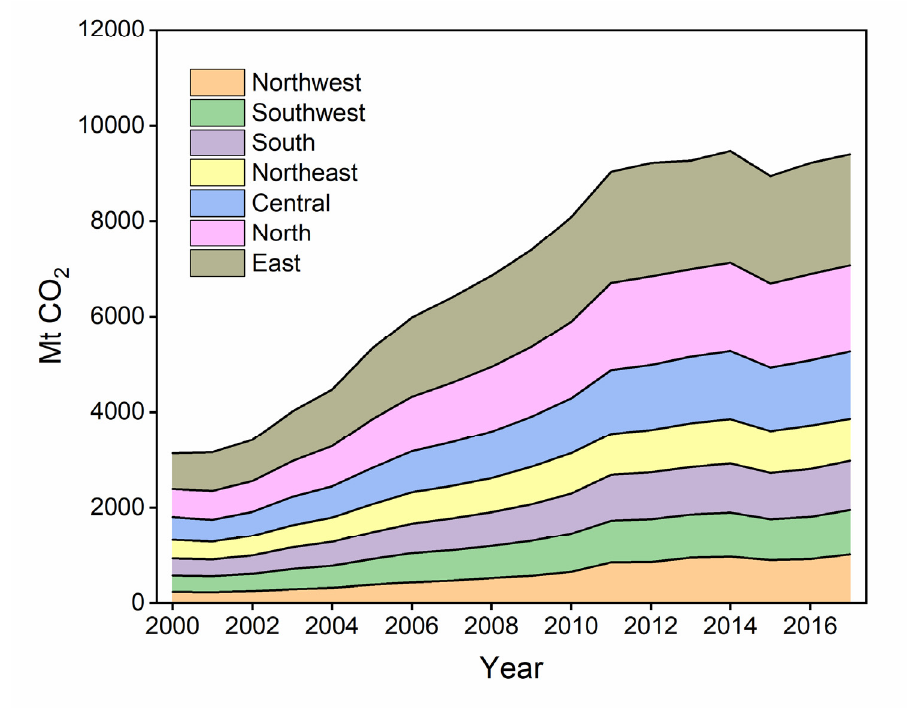
Figure 4. Stacked area map of annual CO 2 emissions in different regions in China during 2000–2017.